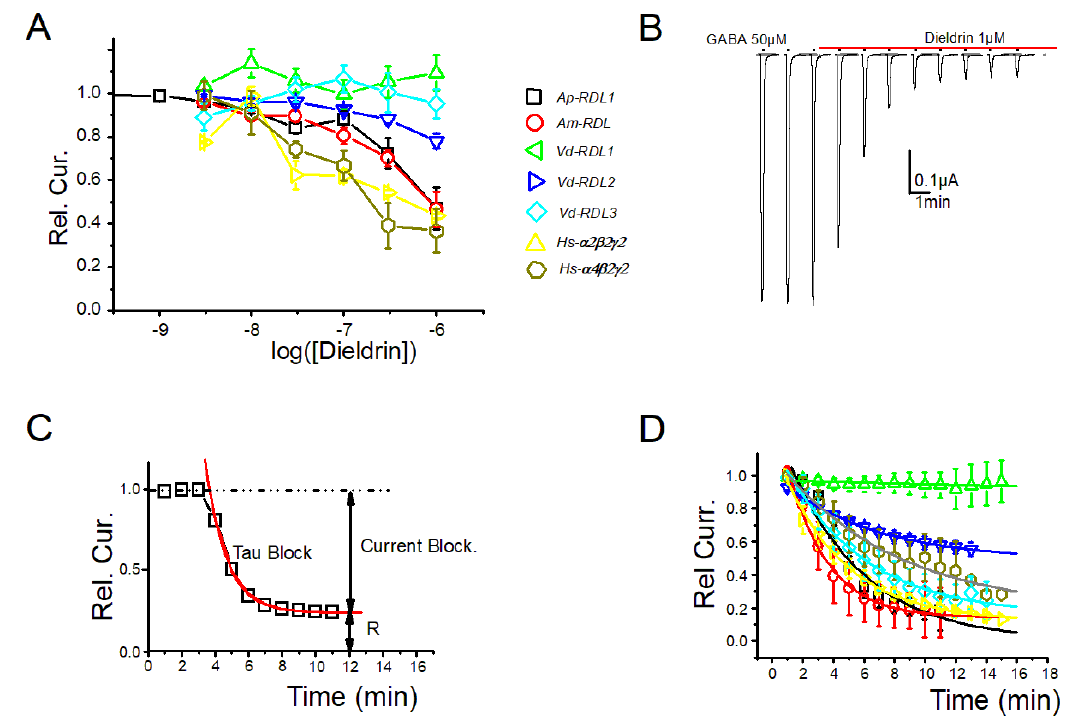
Figure 6. ( A ) Dose–response curves for dieldrin in conditions similar to Figures 4 and 5 (single and simultaneous application of GABA and each dieldrin concentration) obtained for the seven GABA-A receptors: RDL fom A. pisum and A. mellifera , RDL1, RDL2 and RDL3 from V. destructor , and α 2 β 2 γ 2 and α 4 β 2 γ 2 from H. sapiens . ( B ) Representative current traces of Ap -RDL1 in response to repetitive application of GABA (50 µ M) before and during continuous perfusion of dieldrin (1 µ M). ( C ) The time course of the inhibition by dieldrin of these GABA-induced current amplitudes ((Rel.Cur.) can be approximated by a single exponential that allows to extract Rel.B (relative current block, see Materials and Methods) and a time constant Tau-Block. ( D ) The fit of the kinetics of the response of seven GABA-A receptors: RDL of A. Pisum and A. mellifera , RDL1, RDL2 and RDL3 of V. destructor , and α 2 β 2 γ 2 and α 4 β 2 γ 2 of H. sapiens to dieldrin gave Tau-Block and Rel.B for each receptor (see Figure 7).